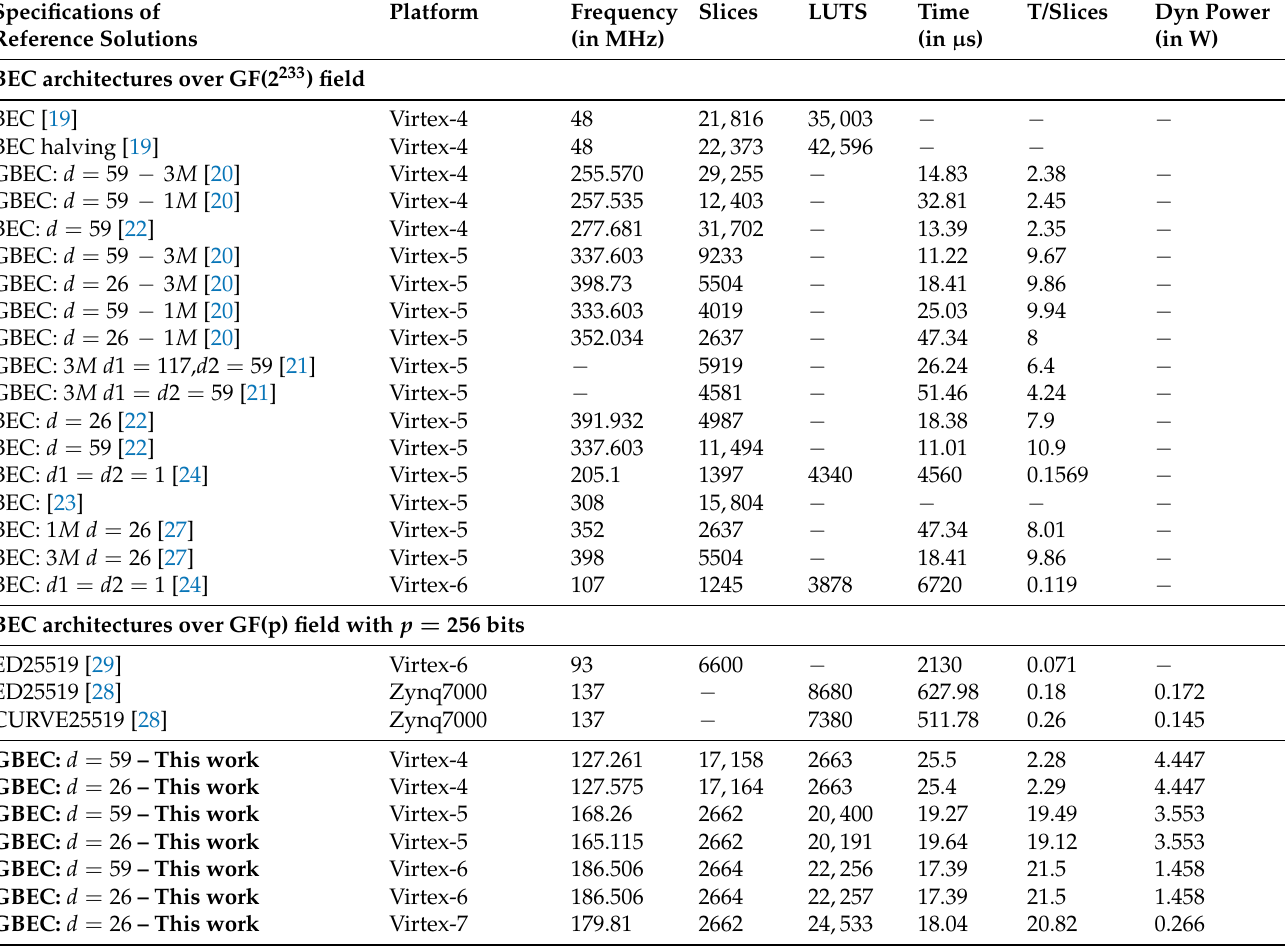
Table 5. Performance comparison with state-of-the-art